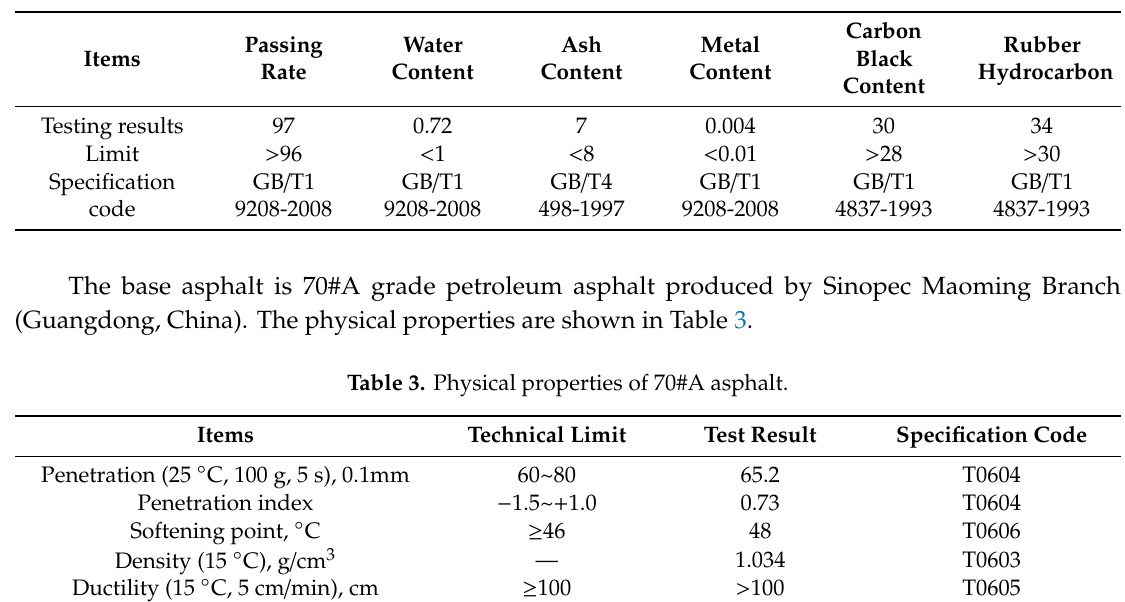
Table 2. Physical properties of 80# mesh waste rubber powder (%).